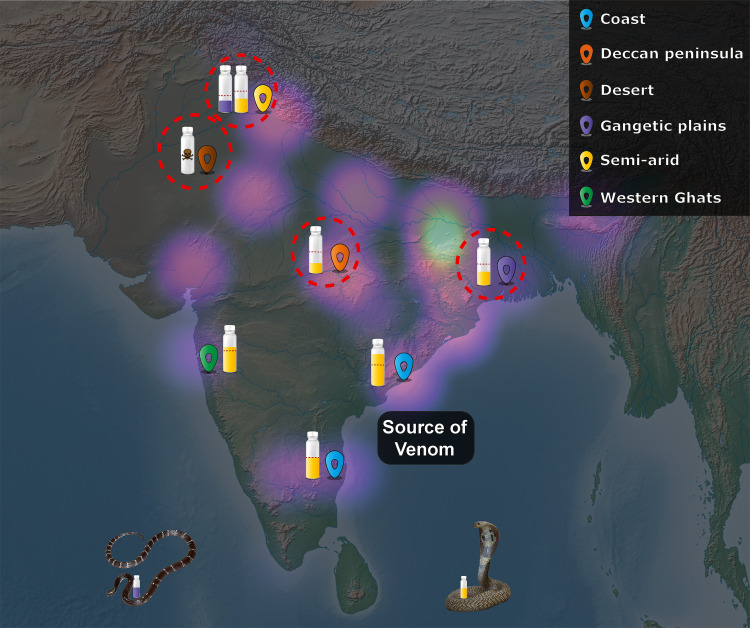
The negative impact of biogeographic venom variability on Indian snakebite therapy.This figure depicts the repercussions of biogeographic venom variability on snakebite treatment in India. Antivenom vials indicate the relative differences in neutralisation potencies against the geographically distinct populations of N. naja (yellow), and B. caeruleus (purple) in comparison to the source population in southern India, where the red dotted line on the vials represents the marketed neutralising potency of commercial Indian antivenoms. The intensity of purple clouds on the map is indicative of the estimated standardised snakebite death rates per million reported by Suraweera et al. 2020 [6], where the brighter regions represent the major hotspots. Geographical locales are defined by the box in the top right. The map of India shown here was prepared with QGIS 3.8 [43].